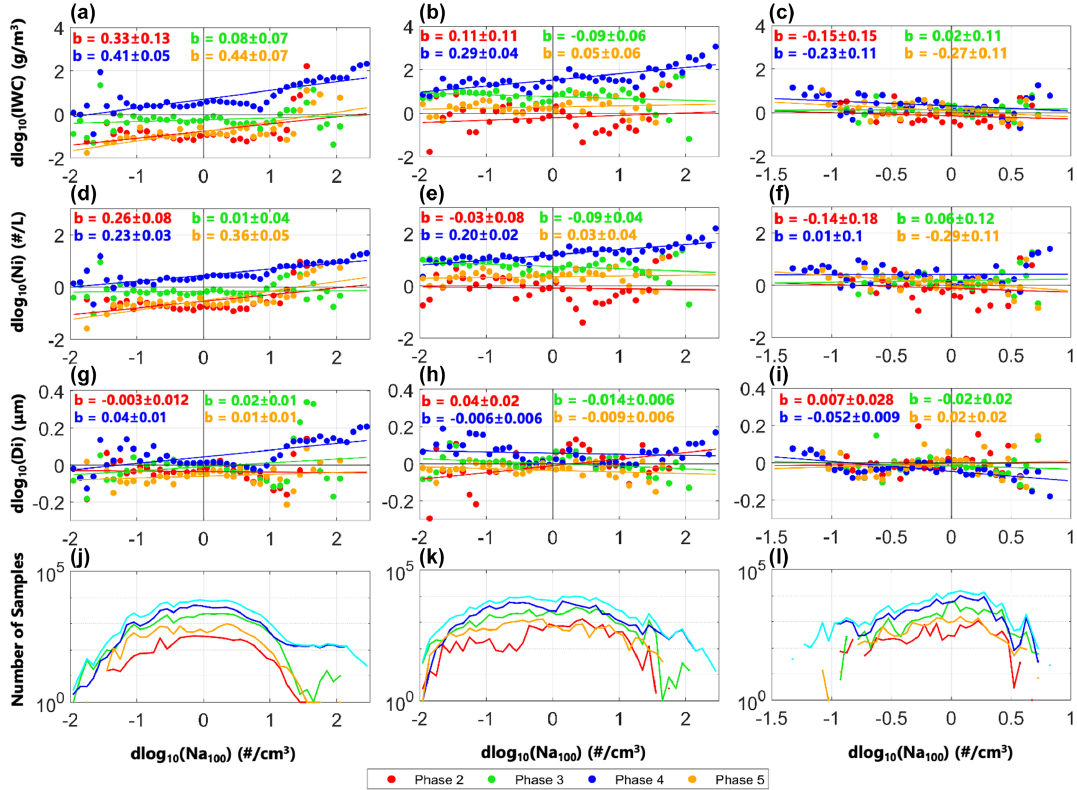
Figure 10. Linear regressions of the delta values of cirrus microphysical properties, i.e., dlog 10 (IWC), dlog 10 (Ni) and dlog 10 (Di) with respect to dlog 10 (Na 100 ) for evolution phases 2 to 5 (various colored lines). Columns 1, 2 and 3 represent 1s observations, 430s observations and simulations, respectively. The slope value and its standard deviation are shown for each linear regression. The number of samples is shown in the last